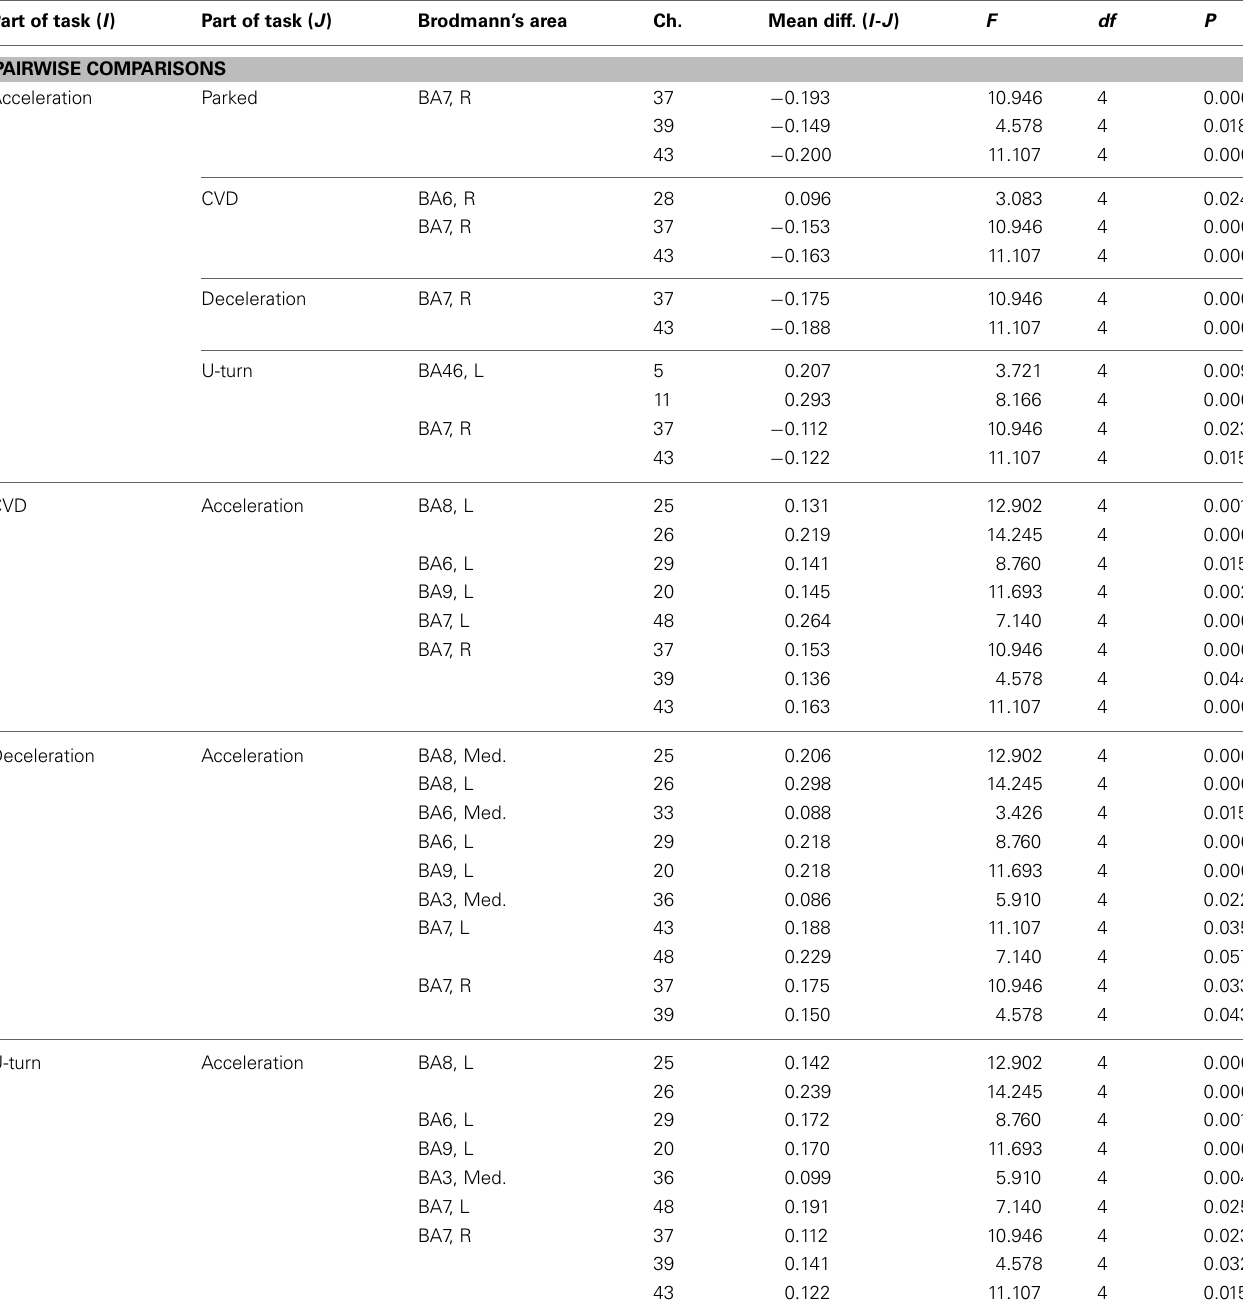
Table A2 | Channels with significant differences in (cid:2) COE between parts of the task in the daytime experiment according to a post-hoc test. Part of task ( I ) Part of task ( J ) Ch. PAIRWISE COMPARISONS